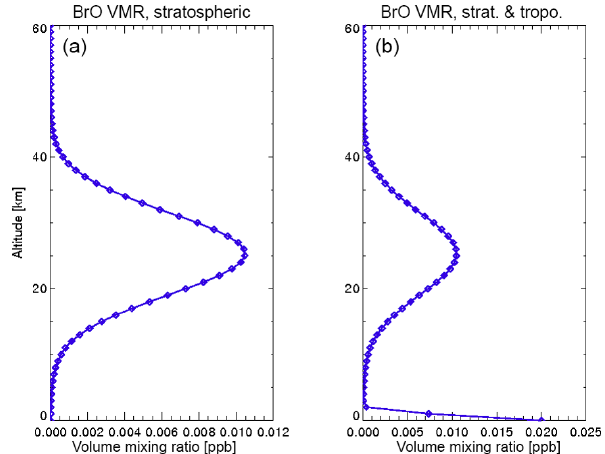
Figure 3. (a) A mostly stratospheric vertical BrO profile used for air mass factors calculations in OMBRO V3. Total BrO, BrO < 15km, BrO < 10km and BrO < 5km are 2 . 05 × 10 13 , 5 . 06 × 10 12 , 1 . 55 × 10 12 and 2 . 87 × 10 11 moleculescm − 2 , respectively. (b) A stratospheric tropospheric vertical BrO profile used to in- vestigate the impact of high tropospheric BrO columns on air mass factors calculations. Total BrO, BrO < 15km, BrO < 10km and BrO < 5km are 6 . 99 × 10 13 , 5 . 45 × 10 13 , 5 . 10 × 10 13 and 4 . 97 × 10 13 moleculescm − 2 ,